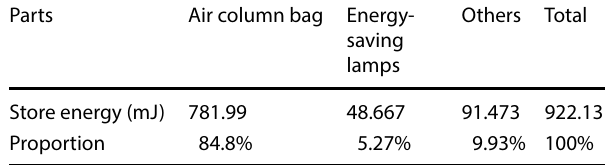
Table 3 Initial inflation pressure: 30 kPa Parts Air column bag Energy-